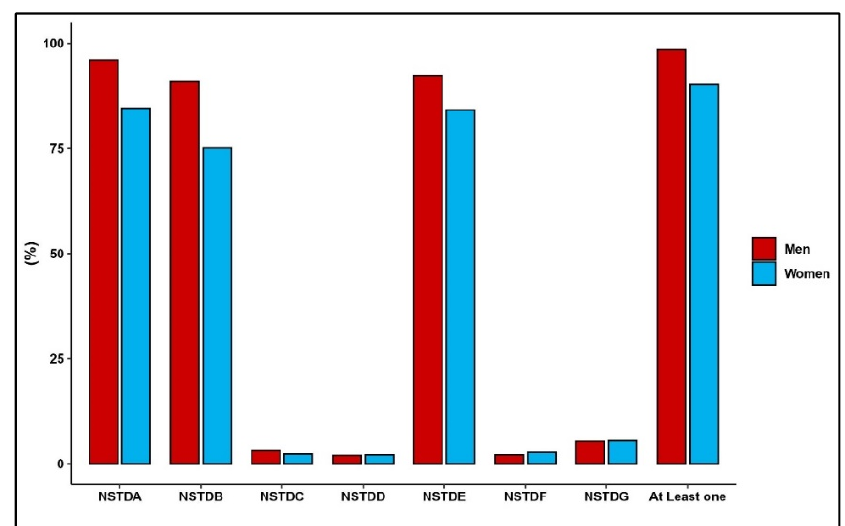
Figure 1. Prevalence of self-reported STI knowledge among men and women in Moshi, Tanzania, 2002–2003: (NSTDA: Gonorrhea, NSTDB: Syphilis, NSTDC: Chlamydia, NSTDD: Genital Ulcers,